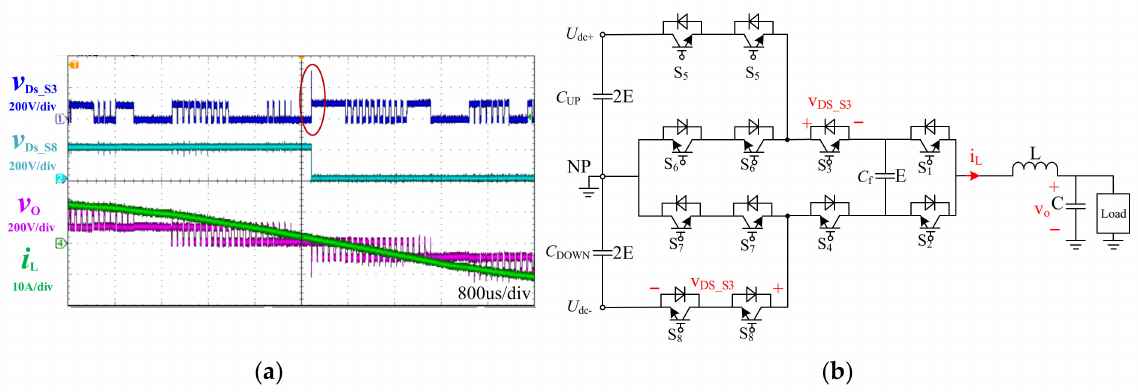
Figure 7. The overvoltage stress issue. ( a ) Experimental waveforms. ( b ) Experimental circuit.